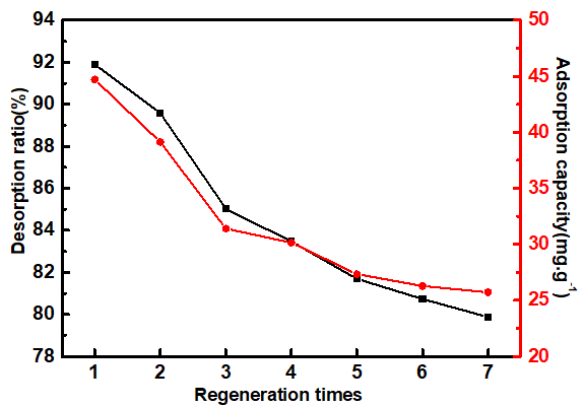
Figure 14. The desorption ratio and adsorption capacity of regenerated fiber.